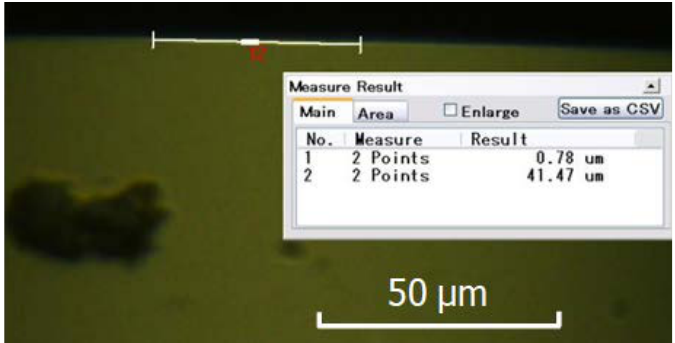
Figure 17. Wear of diamond tool with tip radius of 0.5 mm after cutting along X -axis with negative rake angle (wear land width: 0.78 µm, wear land length: 41.47 µm).